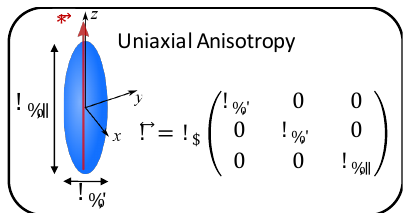
→ n parallel to the molecular long axis for a LC unit volume element and Figure 6. Director Figure 6. Director 𝑛(cid:4652)⃗ parallel to the molecular long axis for a LC unit volume element and permittivity tensor. permittivity